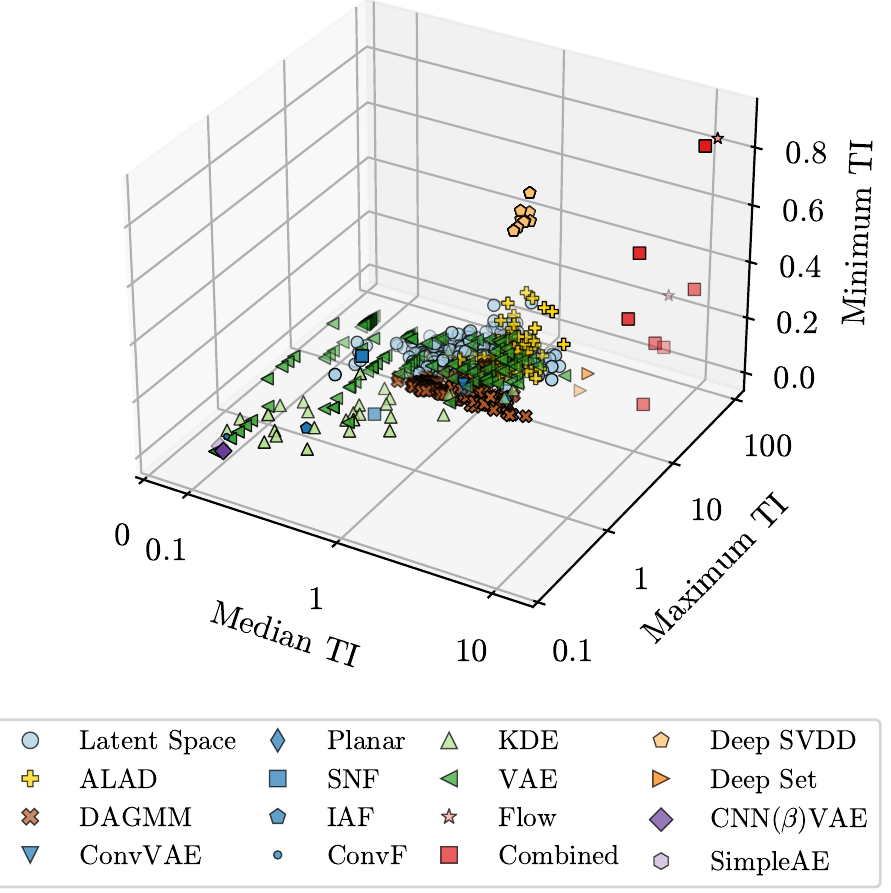
Figure 20: The minimum, median, and maximum best total improvements for each technique across the physics